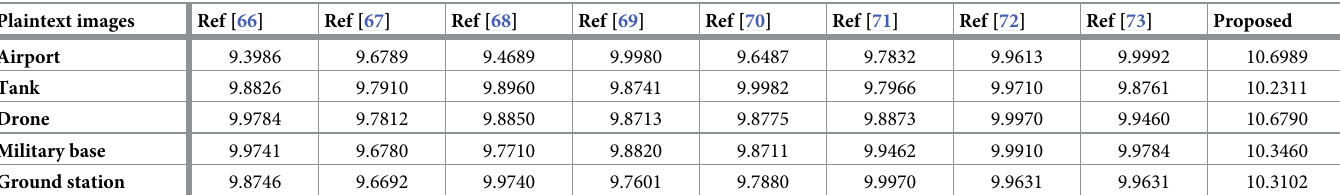
Table 9. Contrast analysis.